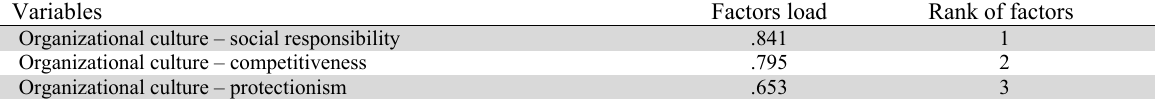
The summary of organizational culture factors influencing on firm performance Variables Organizational culture – social